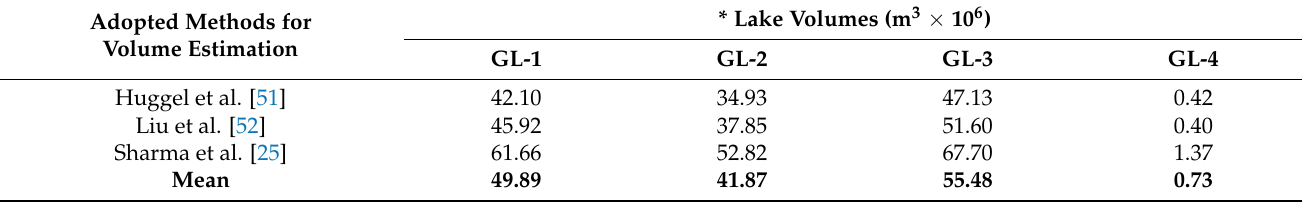
Table 5. Results of volume estimation and means were used in the study for Emmer and Vil í mek [54] methodology. Adopted Methods for Volume